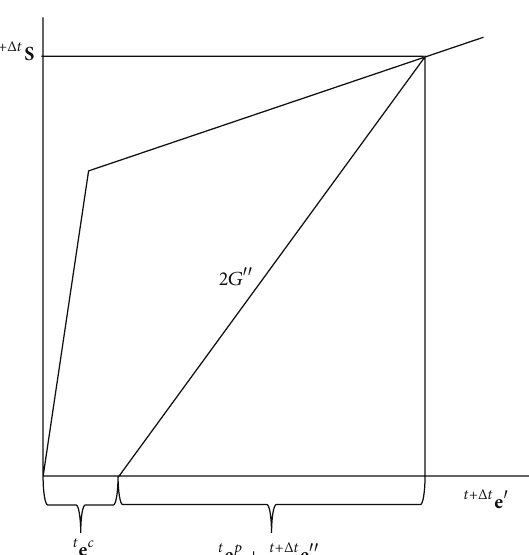
Figure 2: Proposed first stage quasi-elastic